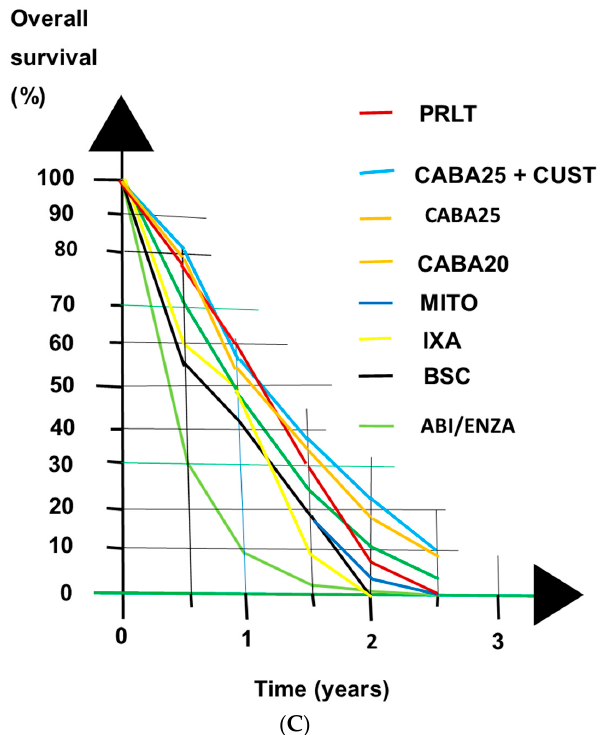
Figure 2. ( A ) PRLT resulted in the best median PSA decline ≥ 50% of the seven treatments evaluated,